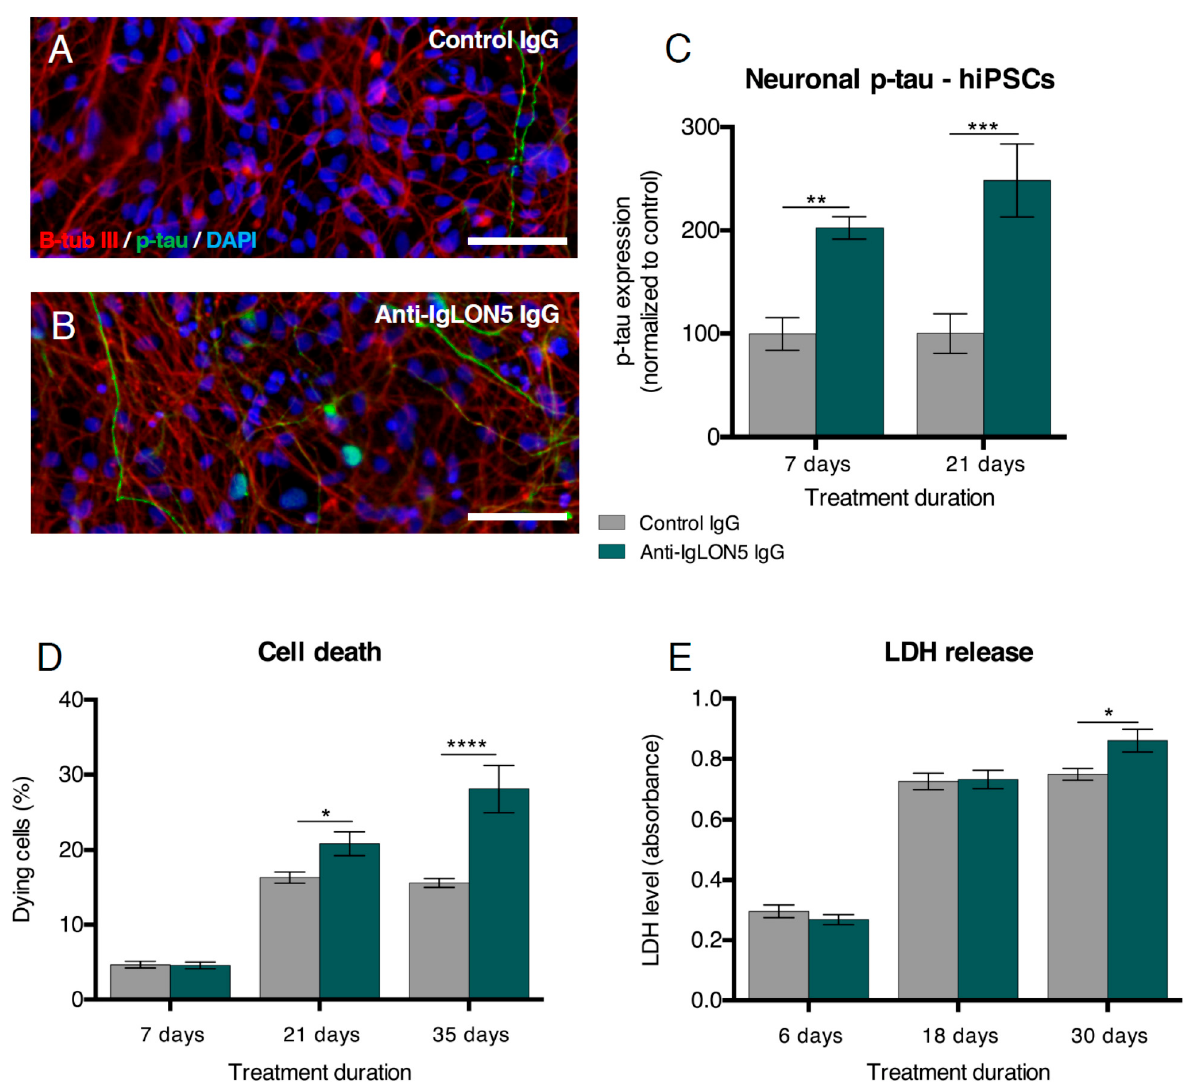
Figure 4. Anti-IgLON5 antibodies increase cell death in induced pluripotent stem cell (hiPSC)-derived neural cultures. Cultures treated with anti-IgLON5 IgG showed an increase in phosphorylated-tau (p-tau) (T205) expression after 7 and 21 days of exposure ( A – C ) ( n = 7–8). Quantification of nuclei with unhealthy morphology revealed an increased percentage of dying cells after 21 and 35 days of exposure ( D ) ( n = 7–18). A lactate dehydrogenase (LDH)-assay (a marker of necrosis) showed increased LDH release to the culture medium of anti-IgLON5 IgG exposed cultures after 30 days ( E ) ( n = 8). Statistical analysis: two-way ANOVA followed by Sidak’s multiple comparisons test. (* p < 0.05, ** p < 0.01, *** p < 0.001, **** p < 0.0001). Scale bars: 50 µm. β -tub III: β -tubulin III